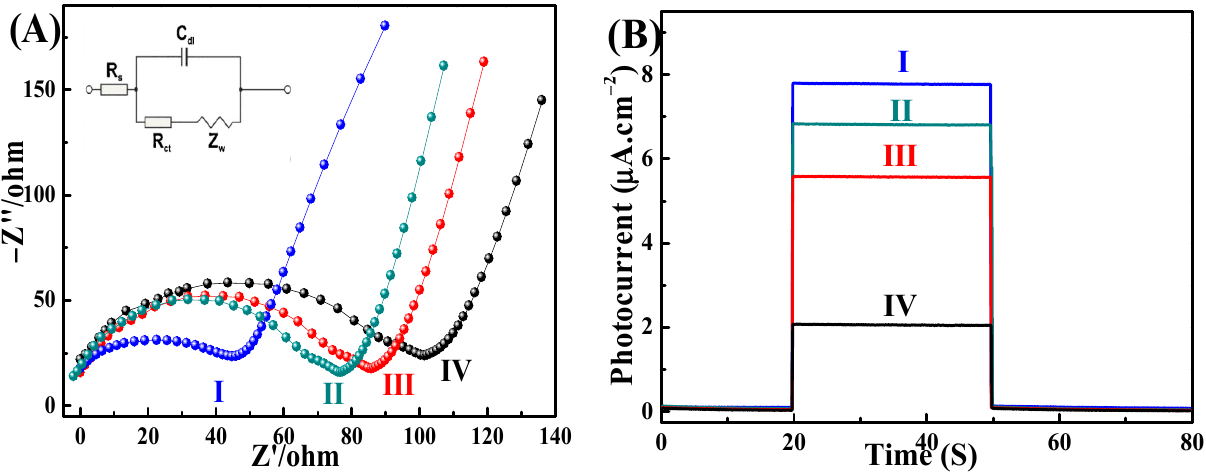
Figure 6. Nyquist plots ( A ) and PEC responses ( B ) of different electrodes: (I) CuS/MoS 2 /Bi 2 WO 6 -5%, (II) CS/CuS/MoS 2 /Bi 2 WO 6 -5%, (III) aptamer/CS/CuS/MoS 2 /Bi 2 WO 6 -5%, and (IV) DCF/aptamer/CuS/MoS 2 /Bi 2 WO 6 -5%. The EIS spectra were achieved in 0.1 M KCl containing 5 mM Fe (CN) 63 − / 4 − .